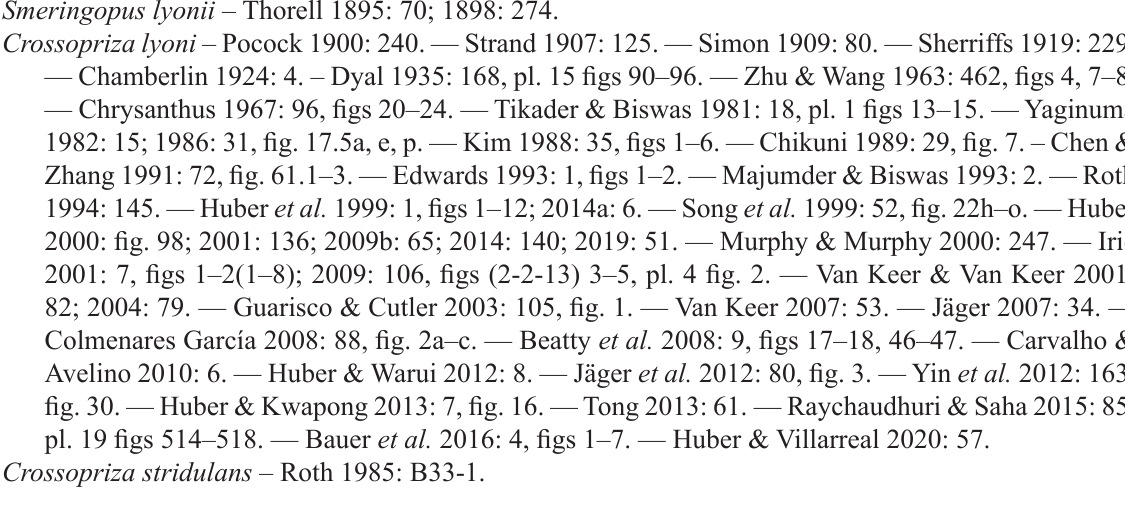
fig. 30. — Huber & Kwapong 2013: 7, fig. 16. — Tong 2013: 61. — Raychaudhuri & Saha 2015: 85, pl. 19 figs 514–518. — Bauer et al. 2016: 4, figs 1–7. — Huber & Villarreal 2020: 57. Crossopriza stridulans – Roth 1985: